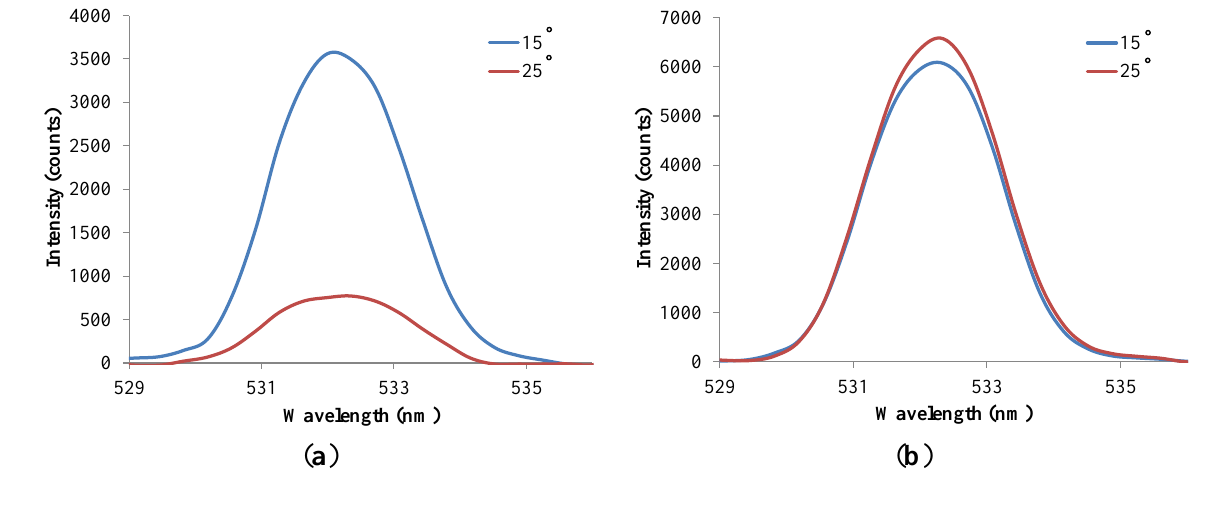
Figure 8. The collected light intensity at different incident angles for excitation light when ( a ) no lens is applied; ( b ) the hybrid lens is